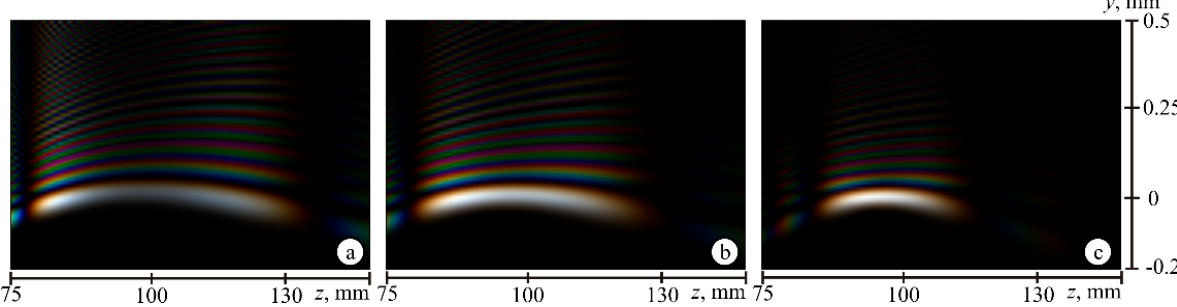
Figure 12. PSF longitudinal distribution patterns with a CoC size limit of 0.04 mm, α = 0.0015 ( z ∈ [75 mm; 150 mm], y ∈ [ − 0.2 mm; 0.5 mm]) for a phase apodized lens n = 3 ( a ), n = 4 ( b ), and n = 5 ( c ) at three wavelengths of the illuminating beam: λ = 460 nm (blue), 550 nm (green), 640 nm (red).